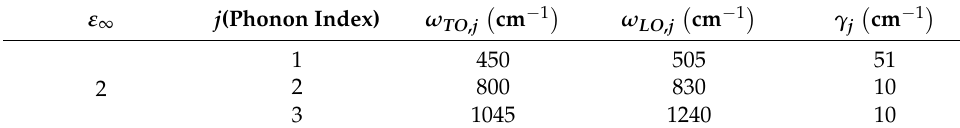
Table 3. Parameters for the calculated IR complex dielectric function of SiO 2 .